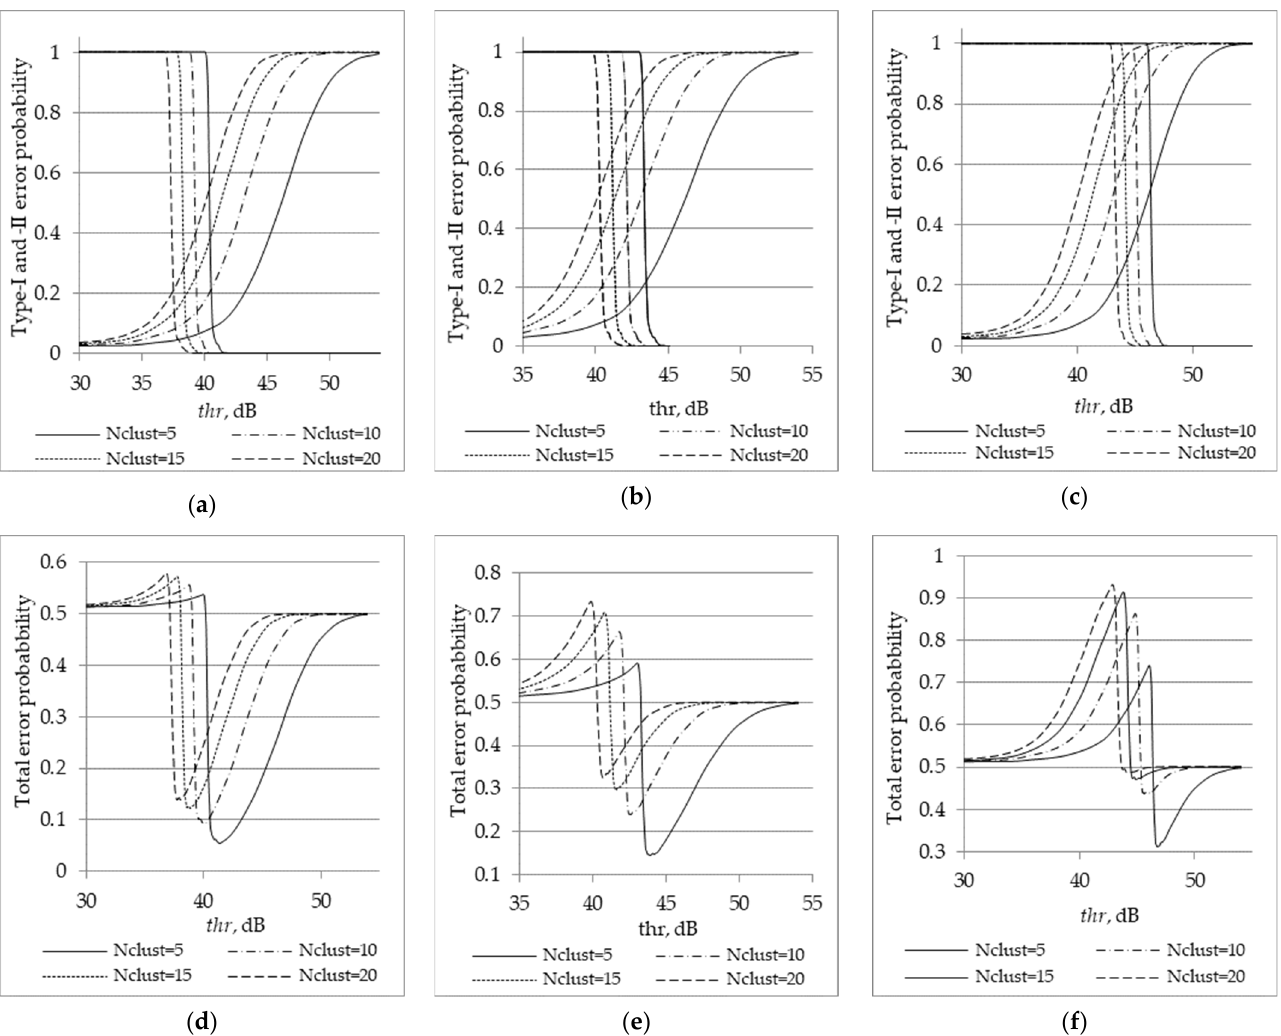
Figure 18. Probabilities of making type-I and -II errors and total error probabilities at standard deviation 25 dB ( a , d ), 27.5 dB ( b , e ) and 30 dB ( c , f ).